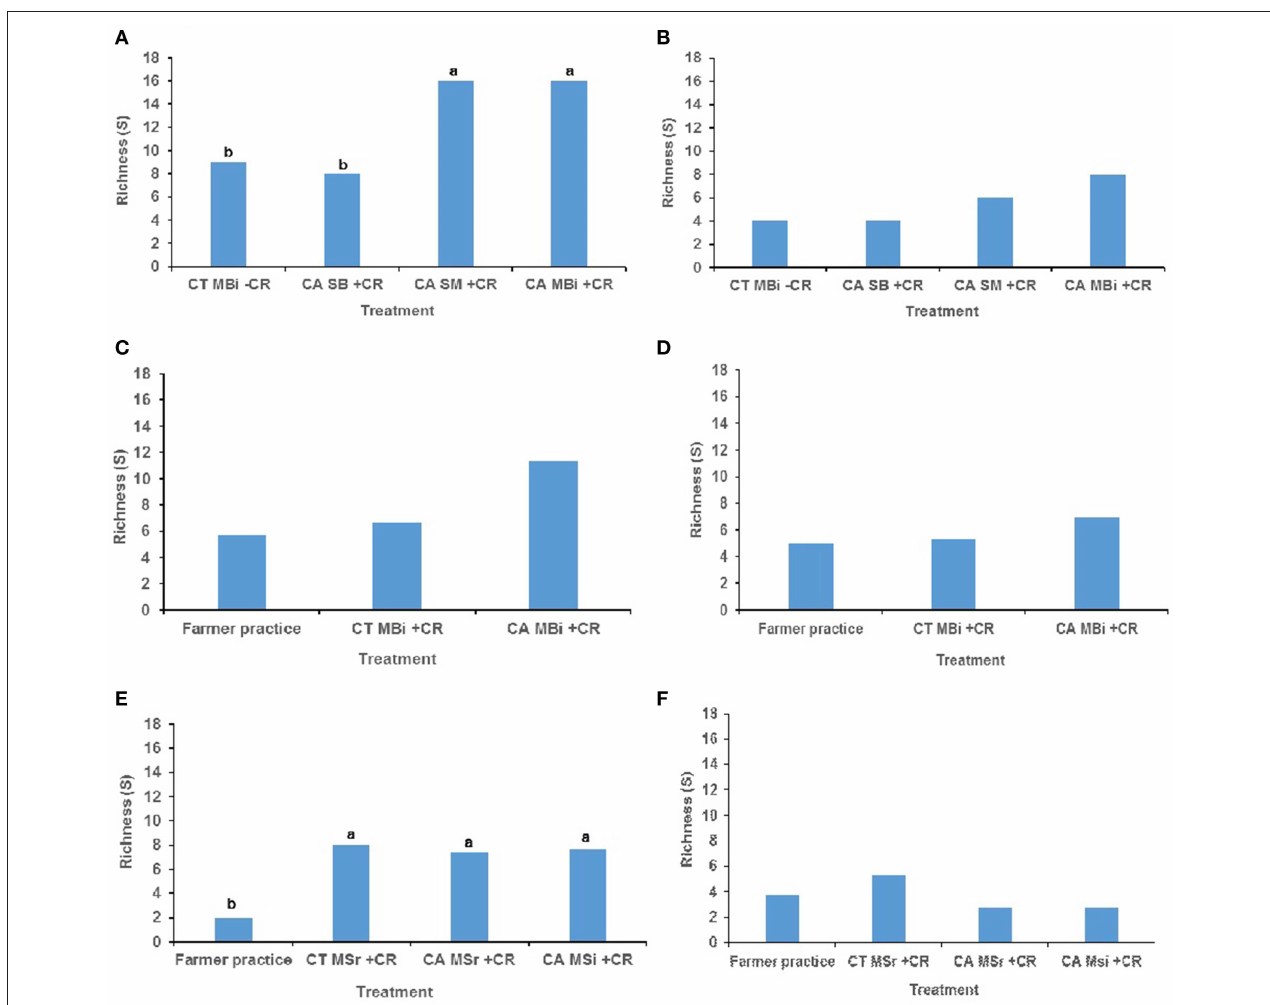
FIGURE 1 | Soil macrofauna diversity (richness) across trials of Embu, Kakamega, and Nyabeda. MT, Medium-term; LT, Long-term; CT, Conventional till; CA, Conservation agriculture (Zero till); SM, Sole maize; SB, Sole beans; MBi, Maize bean intercrop; MSi, Maize-soybean intercrop; MSr, Maize-soybean rotation; CR, Crop residue. (A) Embu MT (0-15 cm, p = 0.027 * ); (B) Embu MT (15-30 cm, p = 0.503); (C) Kakamega MT (0-15 cm, p = 0.329); (D) Kakamega MT (15-30 cm, p = 0.414); (E) Nyabeda LT (0-15 cm, p = 0.029 * ); (F) Nyabeda LT (15-30 cm, p = 0.370). Bars with different lower case letters are statistically significantly different at p <